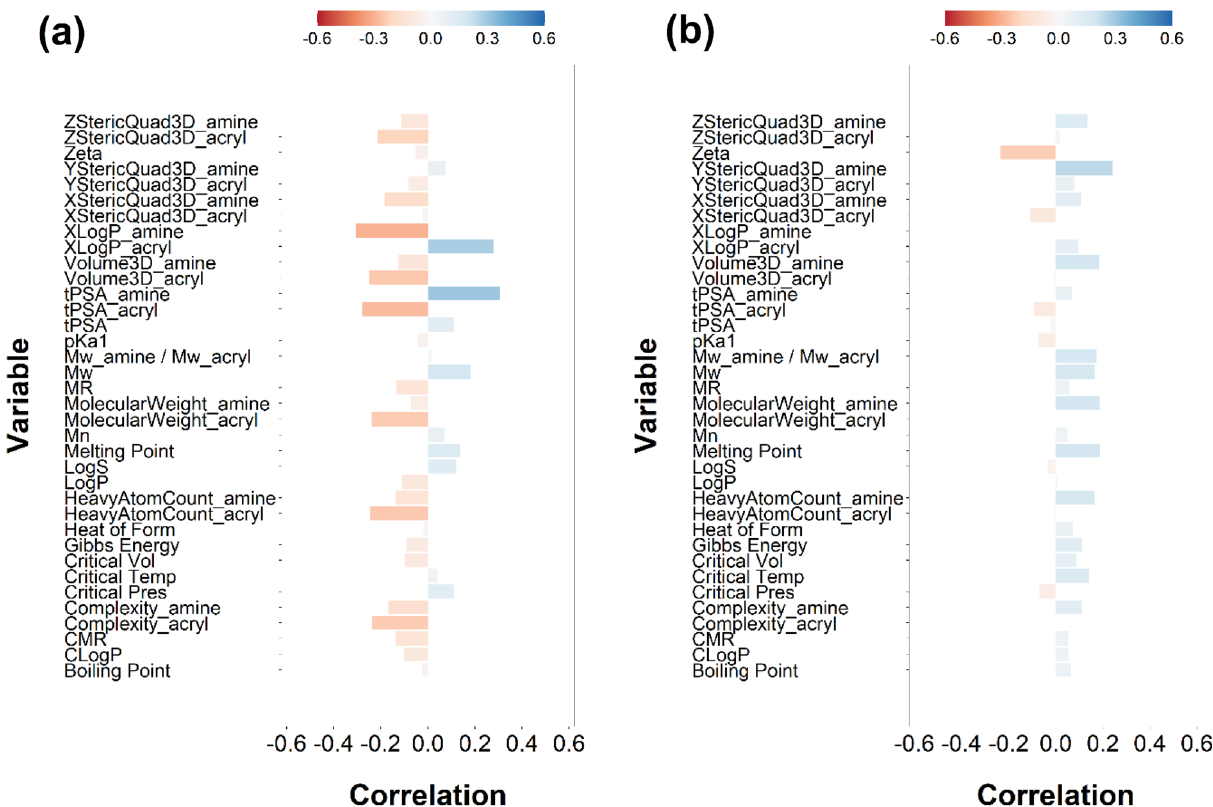
Figure 10. PLS derived correlations for the different PBAEs characteristic (input parameters within the model) and ROS production for PBAE end-capped with e1 ( a ) and e2 ( b ).